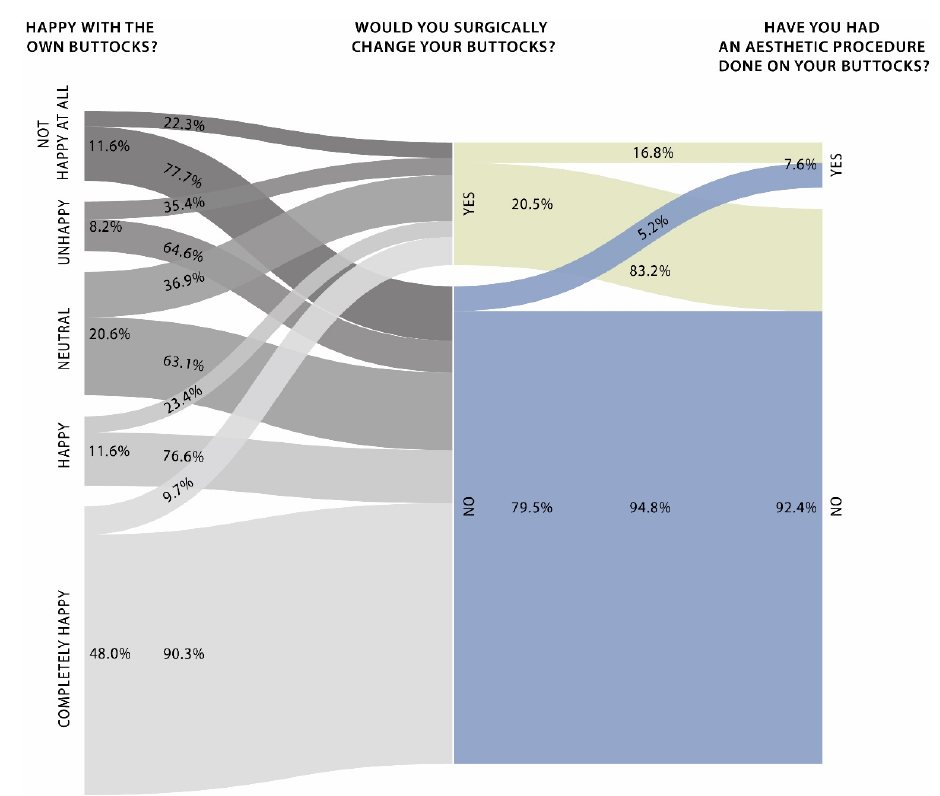
Figure 2. Conversion rate of happiness with one’s own buttocks to considering esthetic surgery and performing esthetic surgery. The alluvial flow diagram shows the conversion rate from the female participants’ happiness about their own buttocks to considering esthetic procedures on the buttocks to the performed esthetic procedures on the buttocks. n = 963 female participants. Hypothesis 1a: The study presented a different view on the buttocks and coping with dissatisfaction in different countries.